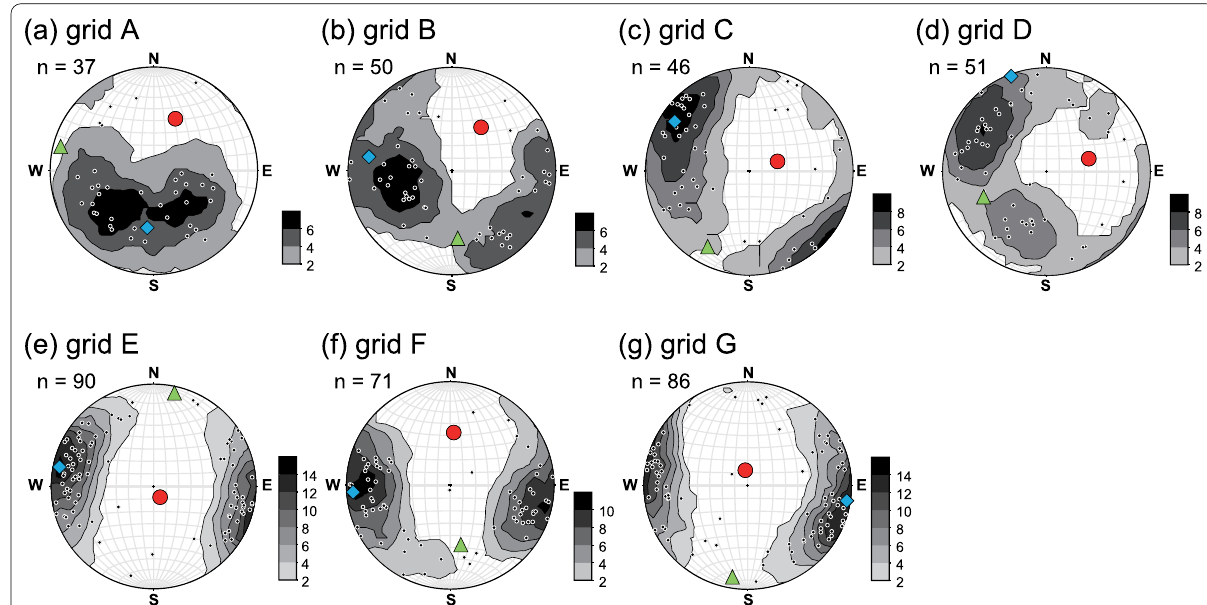
Fig. 5 Dots indicate poles of the tensile crack-filling veins in the damage zone of Nobeoka Thrust. The contour in stereonet was based on the Kamb contouring method with contour interval 2.0. The maximum, intermediate, and minimum permeability directions are indicated by circles, triangles, and diamonds, respectively. All plots are on the lower hemisphere of the Wulff net